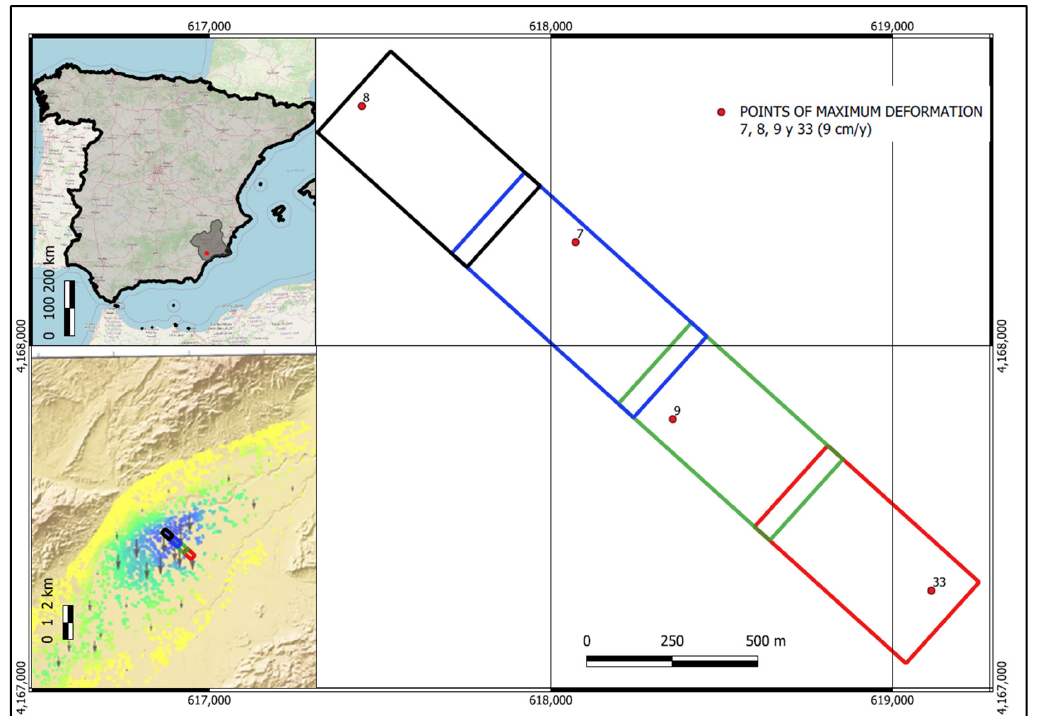
Figure 1. Location of the study area in Lorca, Vía Camino de Puente Alto; the coordinates for the reference system are UTM 30N ETRS89. Points 7,8,9,10,33 have the maximum deformation in the study of [35]. Table 2. Area in hectares for each block studied; h f refers to the forward flight height, and h c refers to cross flight height.